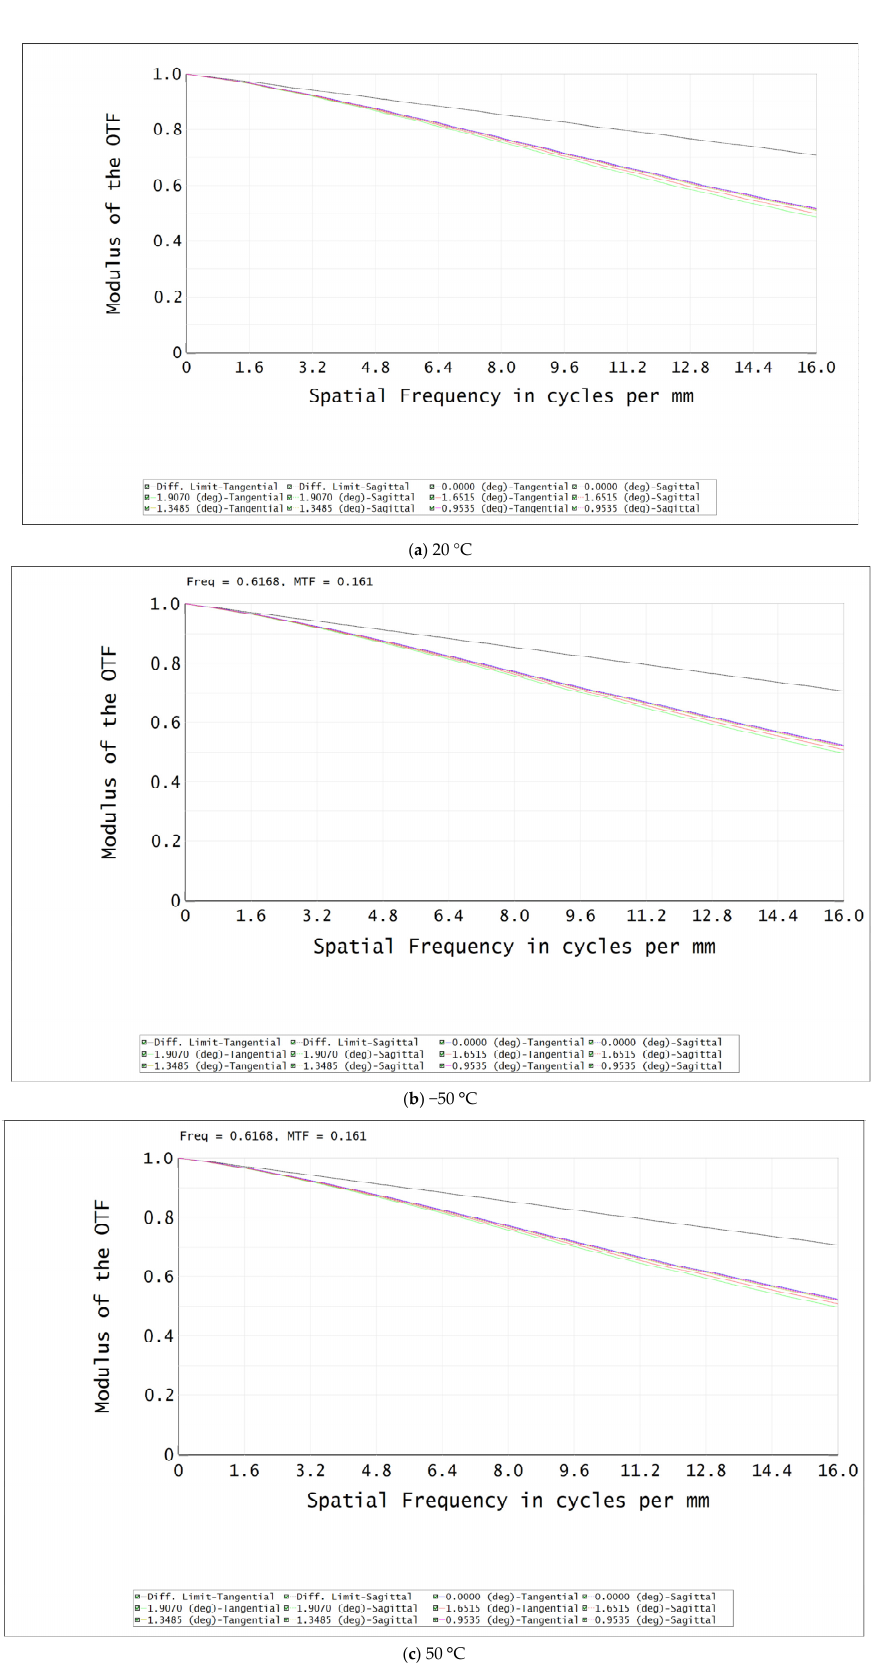
Figure 16. Plots of MTF curves of optical system at different temperatures: ( a ) 20 ° C; ( b ) − 50 ° C; ( c ) Figure 15. Plots of MTF curves of optical system at different temperatures: ( a ) 20 ◦ C; ( b ) − 50 ◦ 50 ° C.